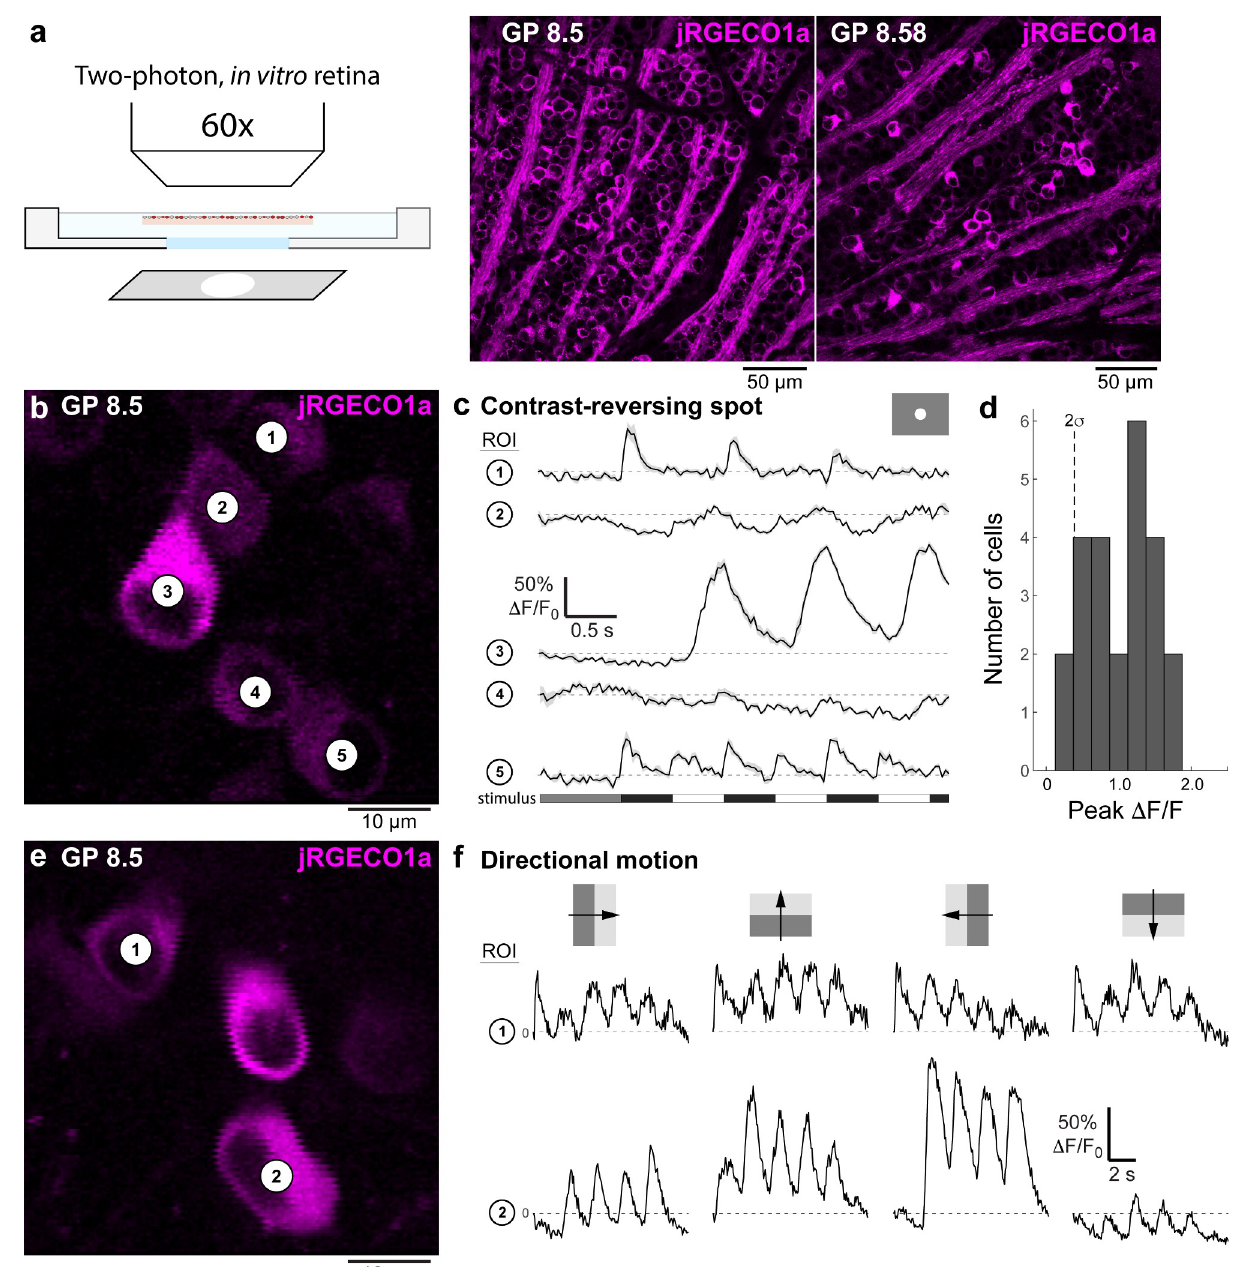
Fig 5. Imaging fluorescence responses of functionally diverse ganglion cell populations in the retina. a, Schematic of the experimental setup (left), and confocal microscopy fluorescence images of retinae taken from GP8.5 and GP8.58 mice (right). b, Two-photon fluorescence image of jRGECO1a- expressing ganglion cells in a whole-mount retina, in vitro (GP8.5). c, Visually-evoked fluorescence responses of the cells indicated in panel b to a contrast-modulated 350 μ m diameter spot (upper right inset). Fluorescence responses were measured in regions of interest (ROIs), defined as the perimeter of each cells’ soma. Stimulus time course shown at bottom (see Methods for details). The labeled ganglion cell population in the GP 8.5 line includes ‘OFF’ types (e.g., cell 1), ‘ON’ types (e.g., cell 3), and ON-OFF types (e.g., cell 5). d, Histogram of response amplitudes across the recorded ganglion cell population (n = 24). Dashed line indicates two standard deviations of the trial-to-trial variability at baseline (first 1s of the response). e, As in b , different retinal area. f, Fluorescence responses of the two cells indicated in panel e during stimulation with oriented drifting gratings (top; grating contrast 100% Michelson; size 500 x 500 μ m; wavelength 500 nm; temporal frequency 0.5 Hz). Traces show examples of a non-direction tuned cell (cell 1) and a direction tuned cell (cell 2).